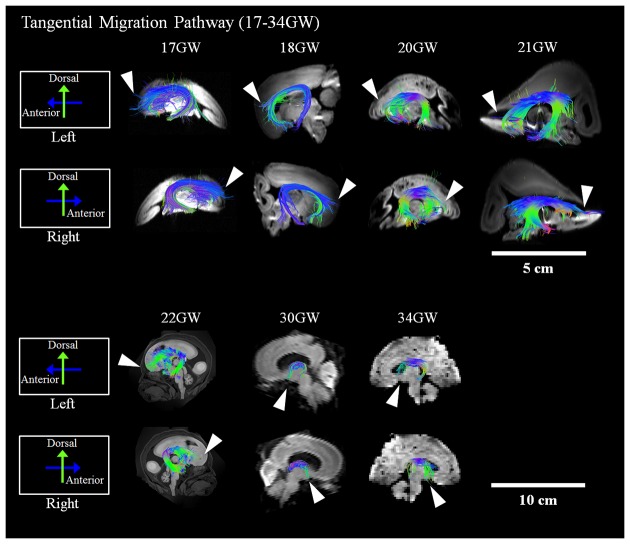
Tangential migration pathways. Tractography at representative ages of the tangential migration pathways are shown in sagittal views. White arrowheads show examples of the tangential migration tract branching into the cerebral walls. Scale bar = 5 cm for 17–21 GW, and 10 cm for 22–40 GW.